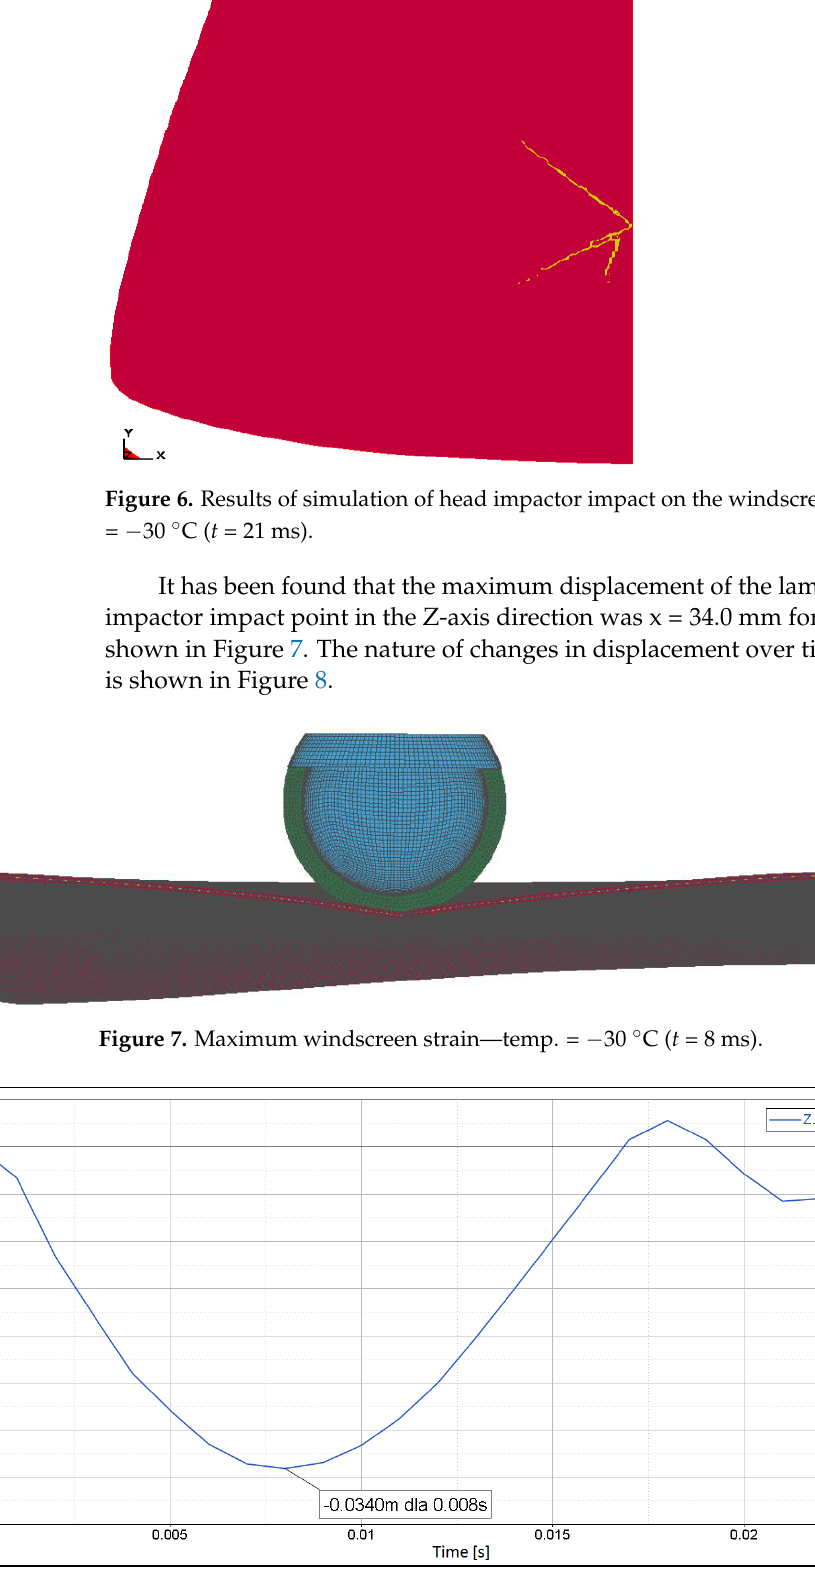
Figure 8. Displacement of windscreen int the point of impactor impact — temp. = − 30 °C (t = 8 ms).